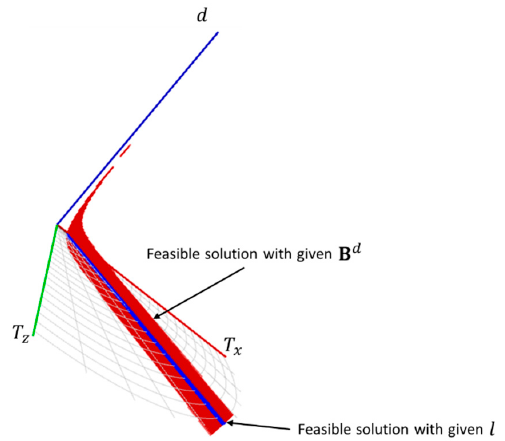
ψ ∈Ψ S and is the blue segment line with .